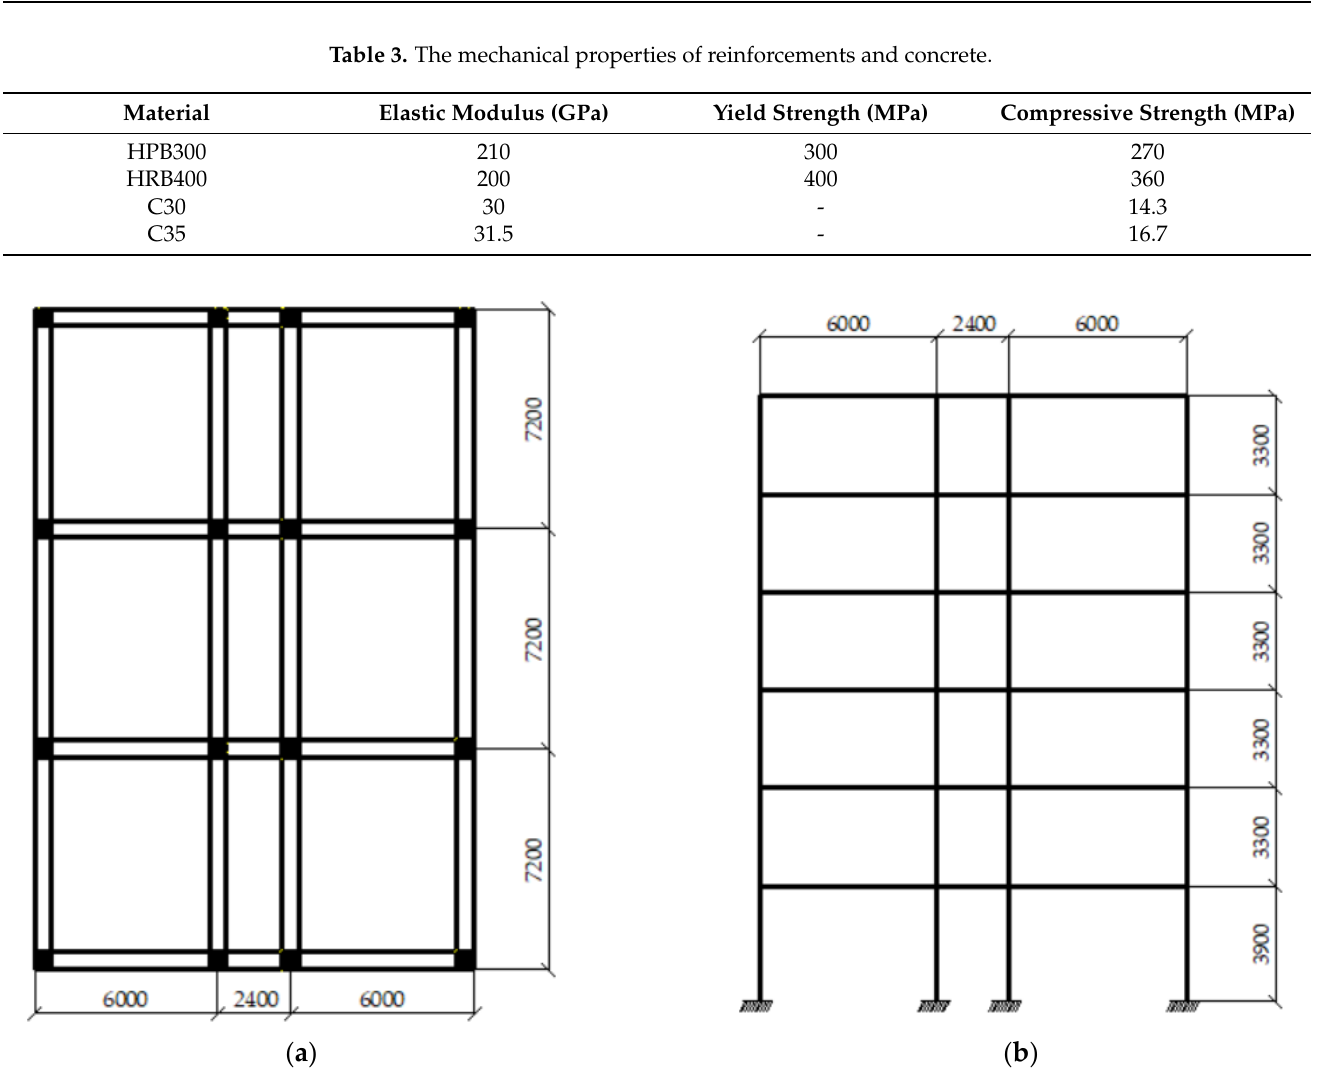
Figure 1. The plan and elevation of the RC frame (unit: mm): ( a ) plan view; ( b ) elevation.